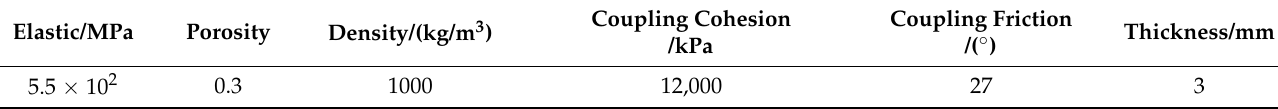
Figure 4. Geocell unit. Table 3. Mechanical parameters of geocell.